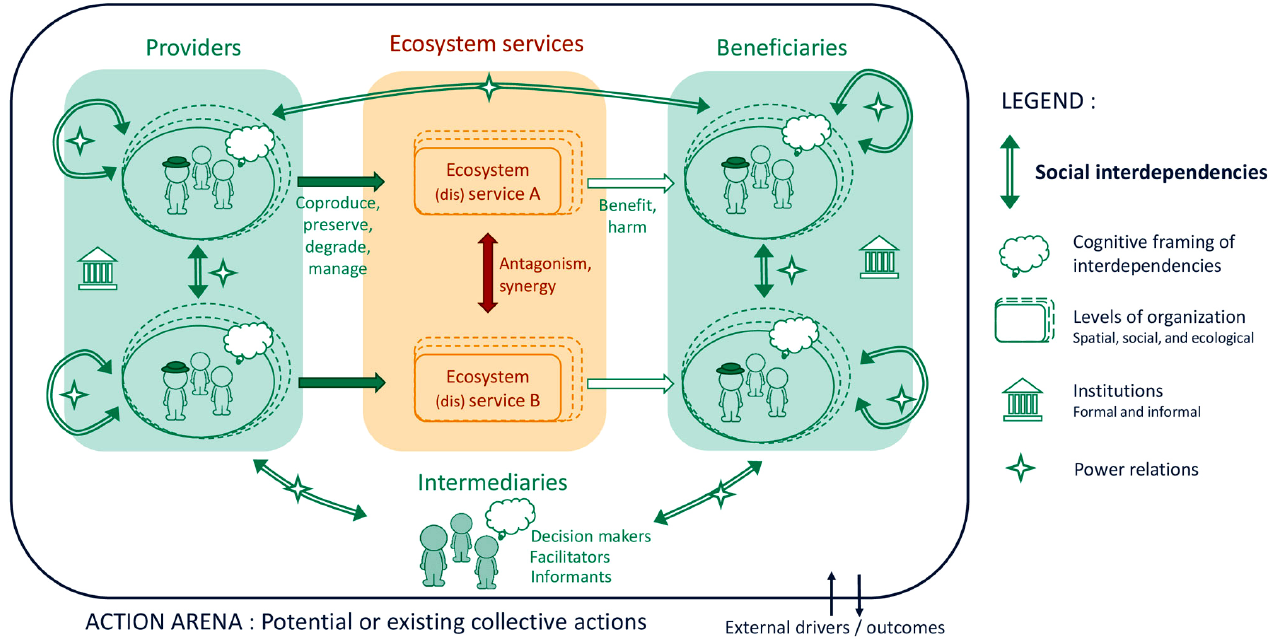
Fig. 1 . Framework of analysis of social interdependencies underlying ecosystem services